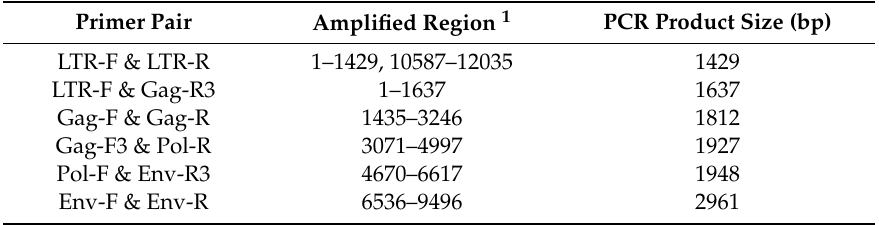
Table 2. PCR-amplified